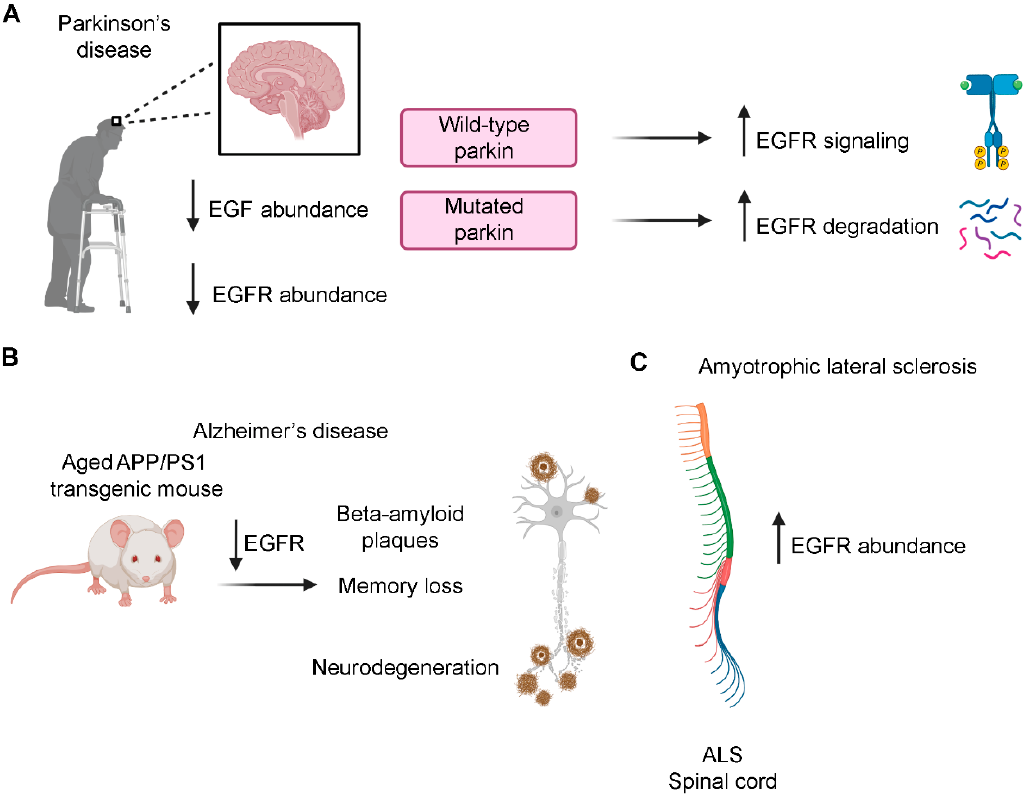
Figure 7. EGFR is associated with neurodegenerative diseases. ( A ) Postmortem brains of patients with Parkinson’s disease show reduced expression of EGF and EGFR. Wild-type parkin sustains EGFR signaling while parkin’s mutations, which are associated with a recessive form of Parkinson’s disease, lead to increased EGFR degradation. ( B ) Aged APP / PS1 double transgenic mice that show plaque formation and memory loss, the hallmarks of Alzheimer’s disease, have reduced EGFR expression that can contribute to neurodegeneration. ( C ) EGFR mRNA is overexpressed in the spinal cord of amyotrophic lateral sclerosis (ALS) patients.